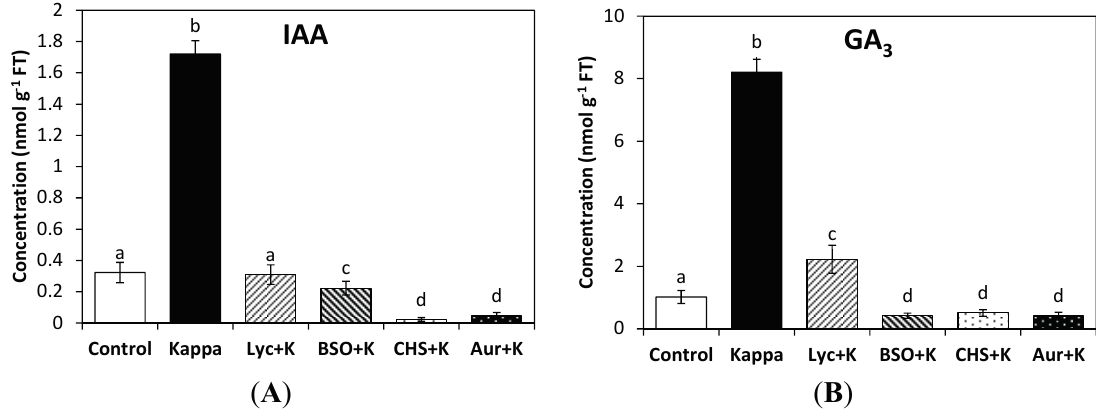
Eucalyptus trees (control) and in trees treated with OC kappa (kappa) or with lycorine and OC kappa (lyc + kappa), buthionine sulfoxime (BSO + kappa), CHS-828 and OC kappa (CHS + kappa) and auranofine and OC kappa (aur + kappa) cultivated for 4 additional months without additional treatment. The level of IAA and GA is expressed in nanomoles 3 per gram of fresh tissue (FT). Bars indicate mean values of three independent experiments and different letters significant differences ( p < 0.05).